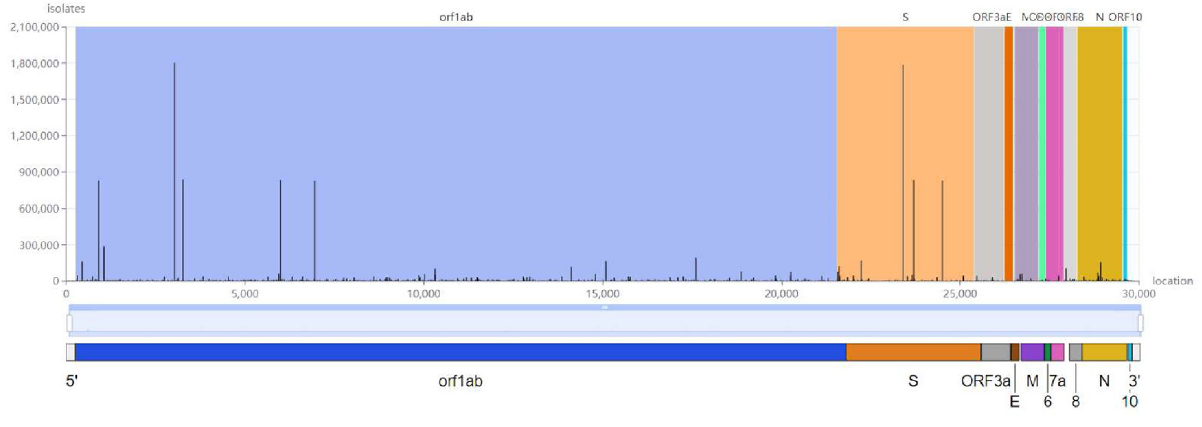
Fig 2. SARS-CoV-2 gene mutation frequency